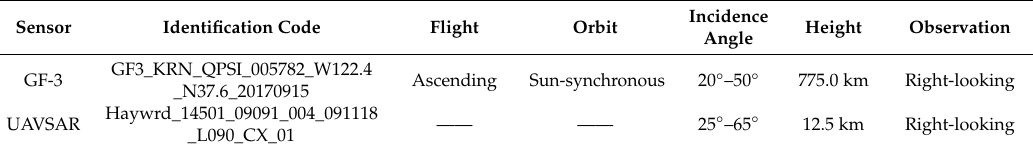
Table 2. Detailed data parameters.